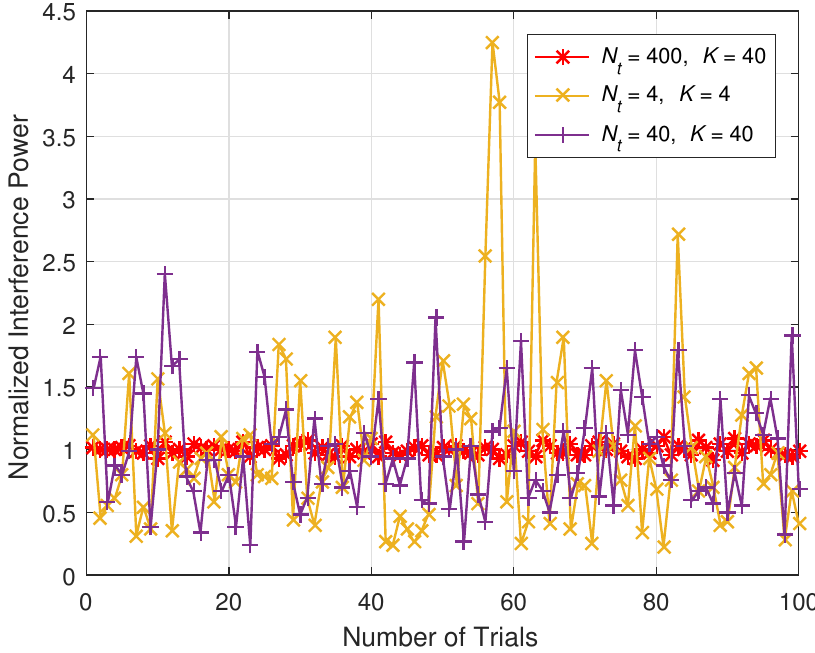
Figure 2. Normalized Interference Power versus Number of Trials: As N t increases, the interference level converges to a certain point that can be easily